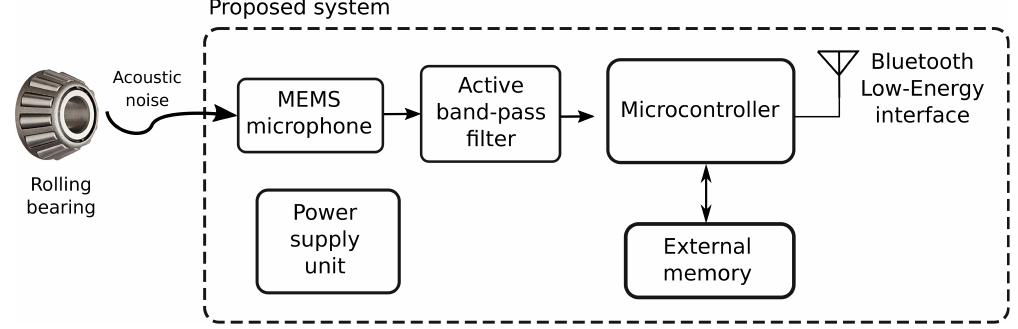
Figure 3. Scheme of the hardware blocks required by the proposed